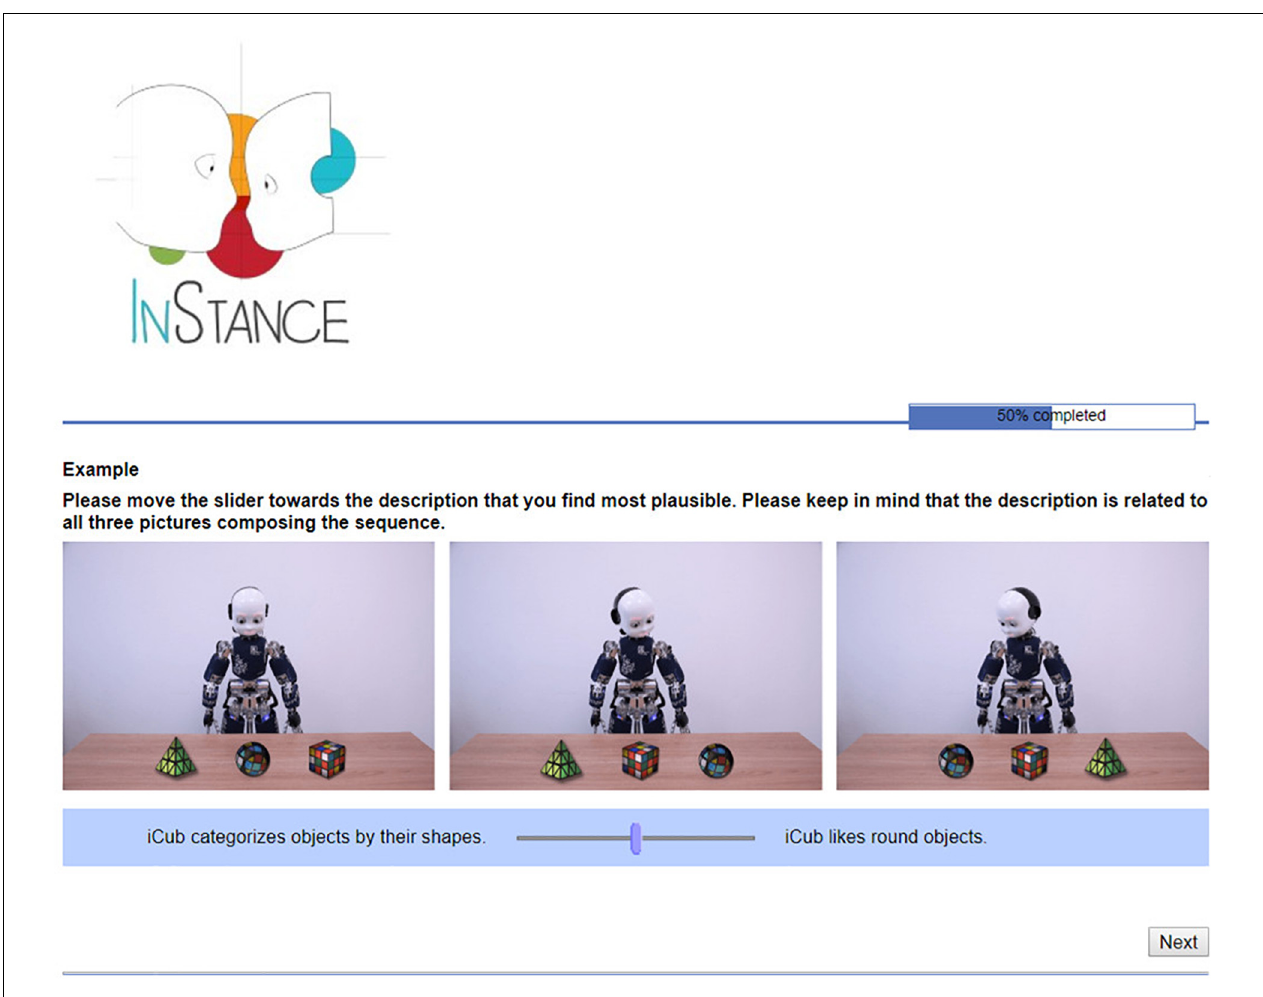
FIGURE 1 | Screenshot from the InStance Questionnaire in